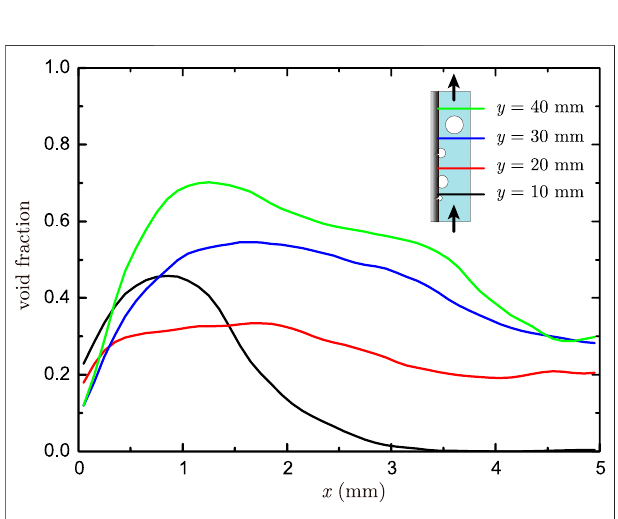
FIGURE14| Localvoidfractionalongtheradialdirection( q (cid:2) 300 kW/m 2